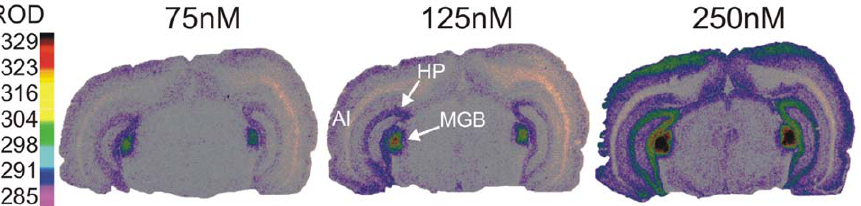
Figure 1. Receptor Binding Assay Indicating High Levels of d -containing GABA A Rs on MGB Neurons: Representative autoradiographs of [ 3 H] gaboxadol binding in young adult rats. Warm colors (red) indicate higher levels of binding while cooler colors (blue) represent lower levels (referenced to Relative Optical Density spectrum at left). At all three concentrations shown here (75 nM, 125 nM and 250 nM), [ 3 H]gaboxadol binds selectively to GABA A Rs in MGB with little binding in brain regions shown in this coronal section, except for hippocampus and upper layers of neocortex. The MGB and hippocampus are indicated by arrows labeled ‘‘MGB’’ and ‘‘HP’’, respectively with primary auditory cortex labeled as ‘‘A1’’.